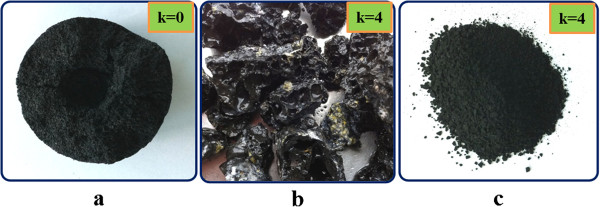
Photographs of as-combusted (a, b) and water-purified (c) samples.